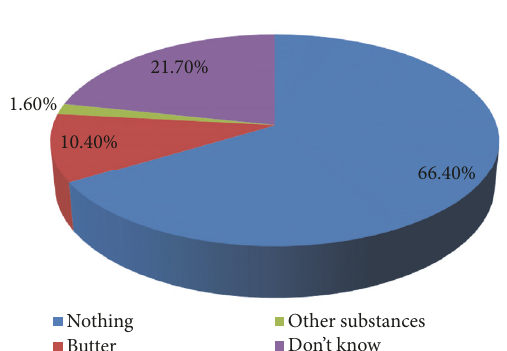
Figure 4: Substances applied on umbilical cord after cutting mentioned by postnatal mothers’ in Addis Ababa health centers, Dec. 1-Jan.30, 2017.